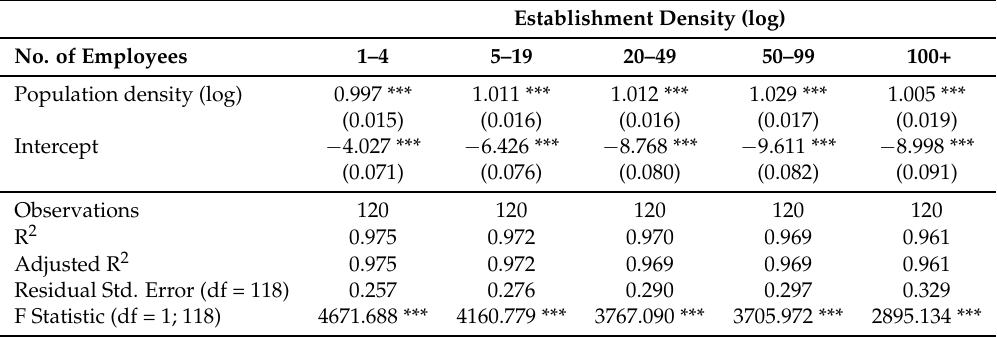
Table 1. Log-Log-Regression of the population density and the commercial establishment densities of five different sizes. Absolute population and establishment numbers on a Governorate level were accessible/extrapolated for the years 2006 to 2015 and then divided by the respective areas of the Governorates to retrieve the